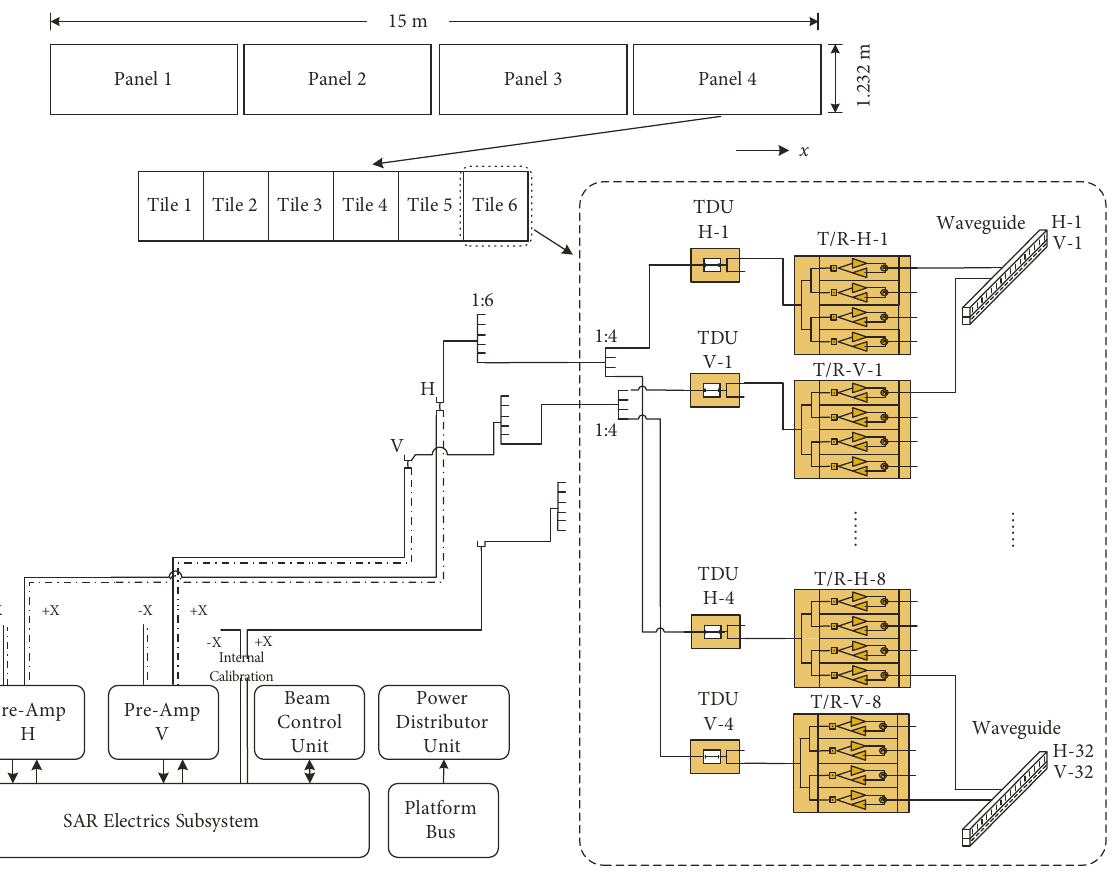
Figure 1: The architecture of the GF-3 SAR antenna system.